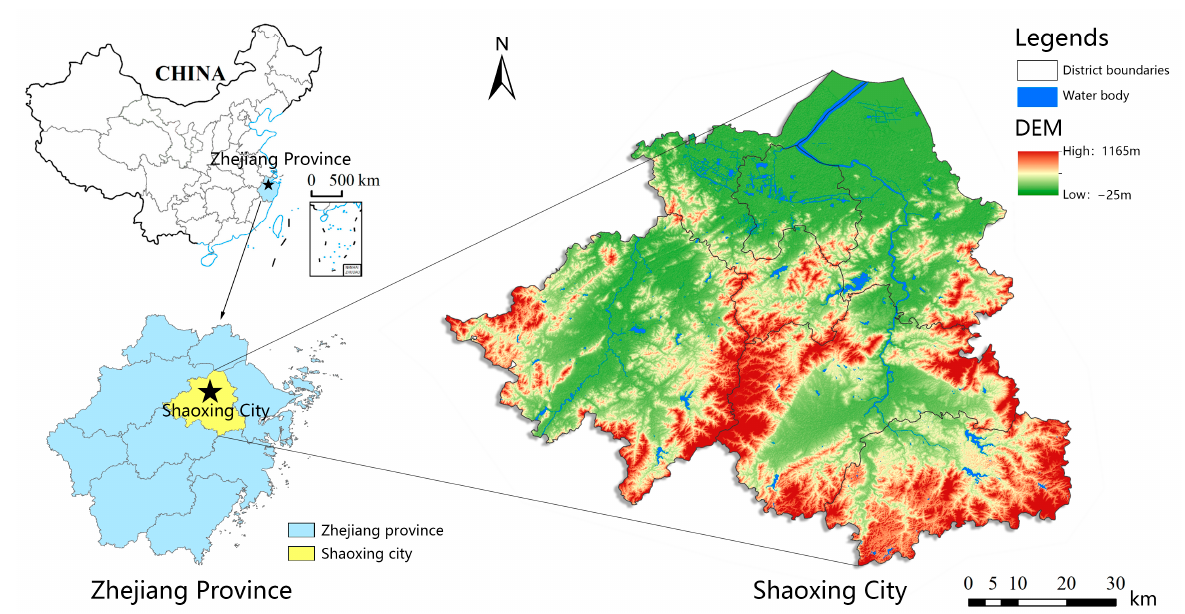
Figure 1. Study Figure 1. Study Area.